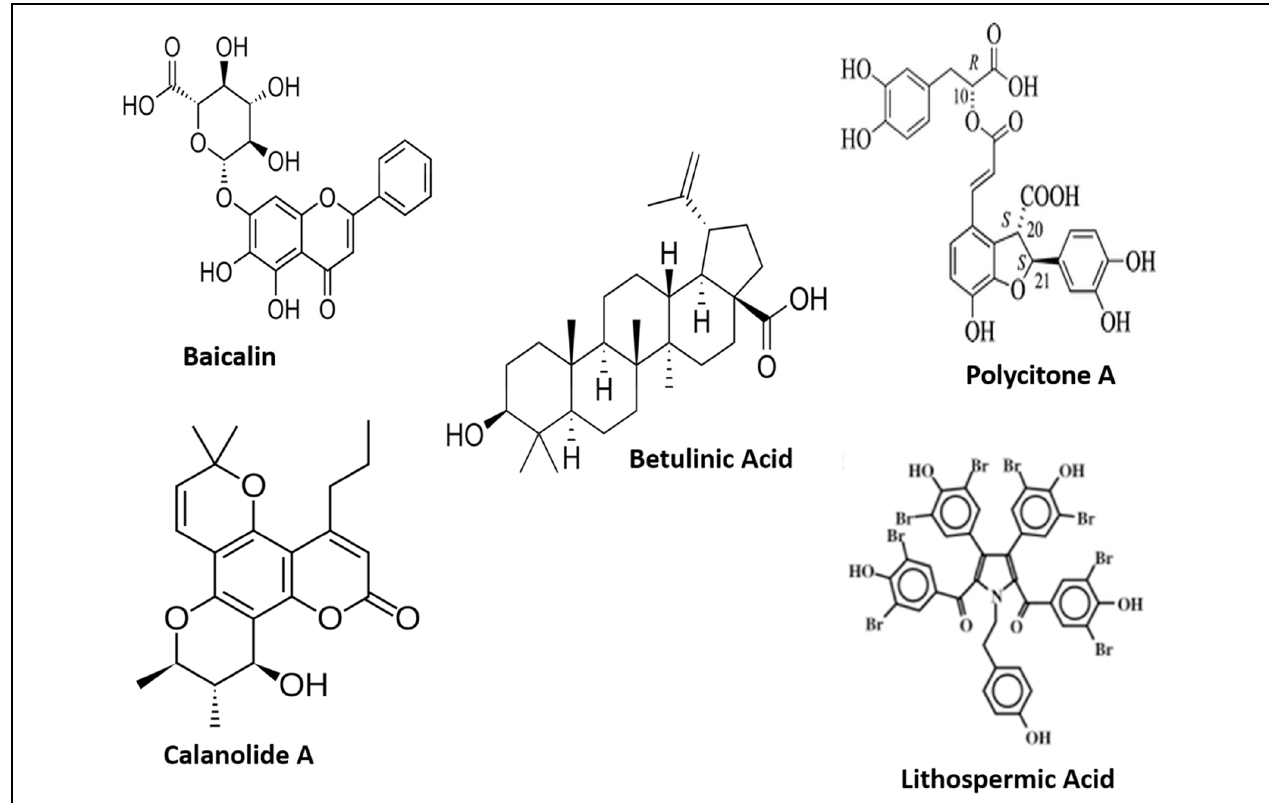
FIGURE 1 | Structural formulae of representative anti-HIV natural products.